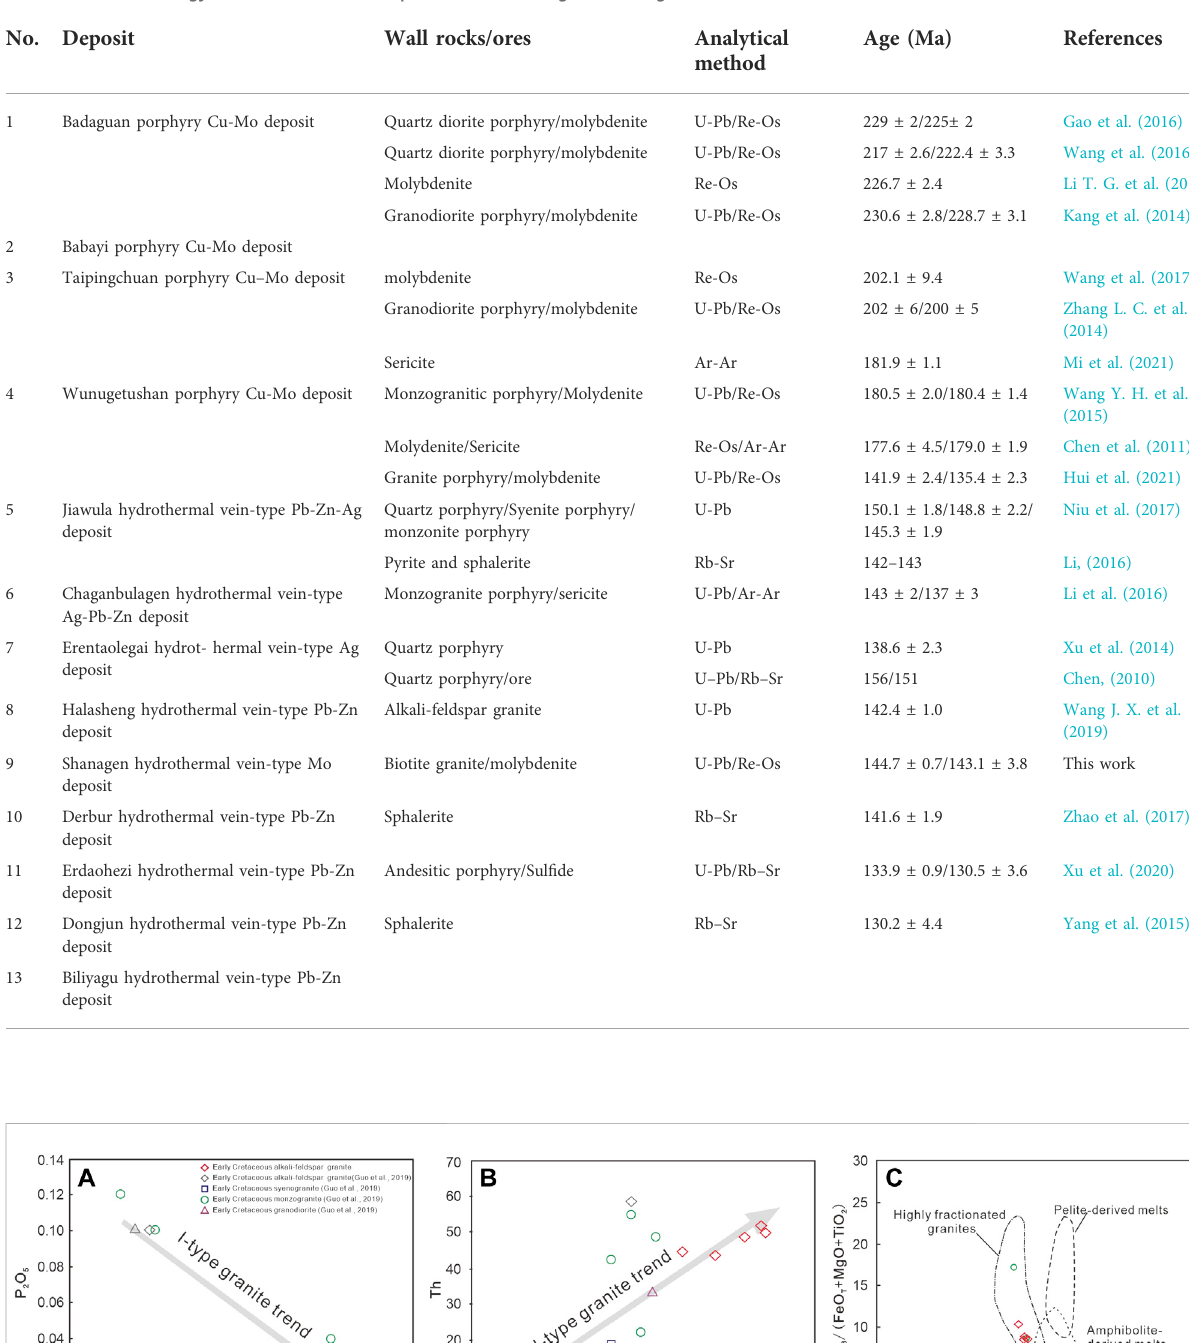
TABLE 4 Geochronology data of some metal deposits in the Derbugan metallogenic.